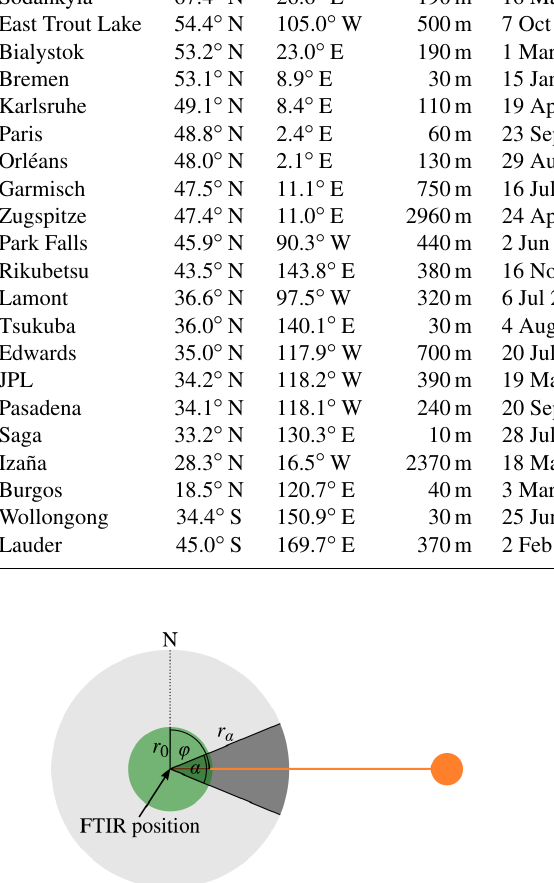
Figure 4. Illustration of the spatial co-location condition. The co- location area consists of a cone in the FTIR viewing direction (i.e. solar azimuth angle ϕ ) with opening angle α and radius r α depend- ing on solar zenith angle ϑ (dark grey). The limit of ϑ = 0 ◦ is a full circle (green). The area remains constant (dark grey and